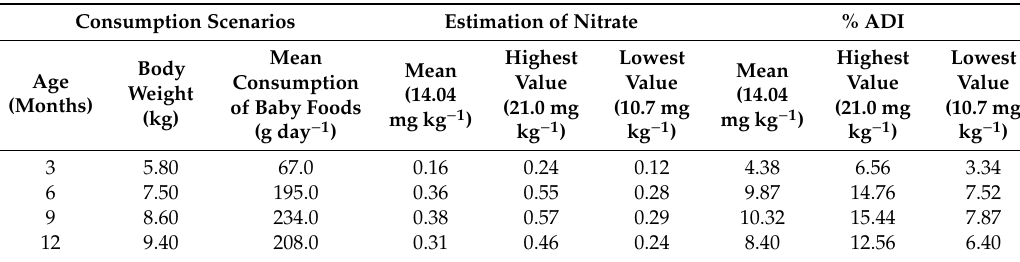
Table 3. Estimated nitrate intake from homogenized meat selected for the study, calculated using consumption information provided by DONALD study and percentage of acceptable daily intake (ADI) for the di ff erent exposure scenarios using the mean, highest and lowest nitrate concentrations in all samples under